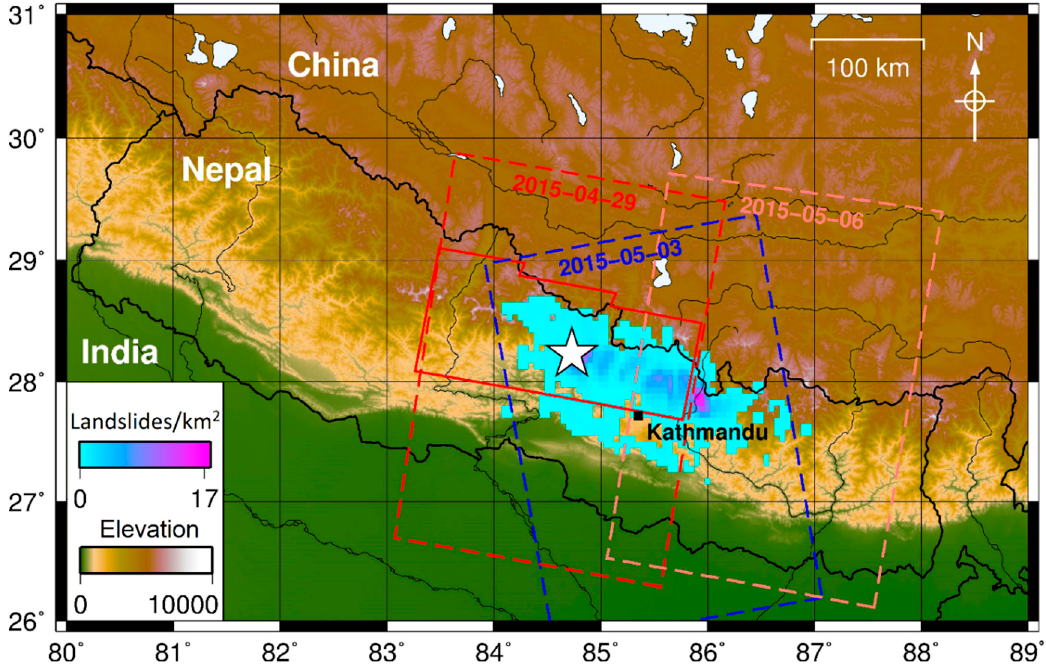
Figure 1. Location map of the 2015 Gorkha earthquake. A white star marks the epicenter of the mainshock on 25 April 2015. The density of earthquake-triggered landsliding was calculated based on the inventory of Roback et al. [2]. The first post-event Sentinel-1a Synthetic Aperture Radar (SAR) acquisitions are shown with dashed lines: ascending track 085 (blue); descending track 19 (red) and descending track 121 (orange). The area of SAR imagery used in this study is from track 19 and is outlined in solid red.